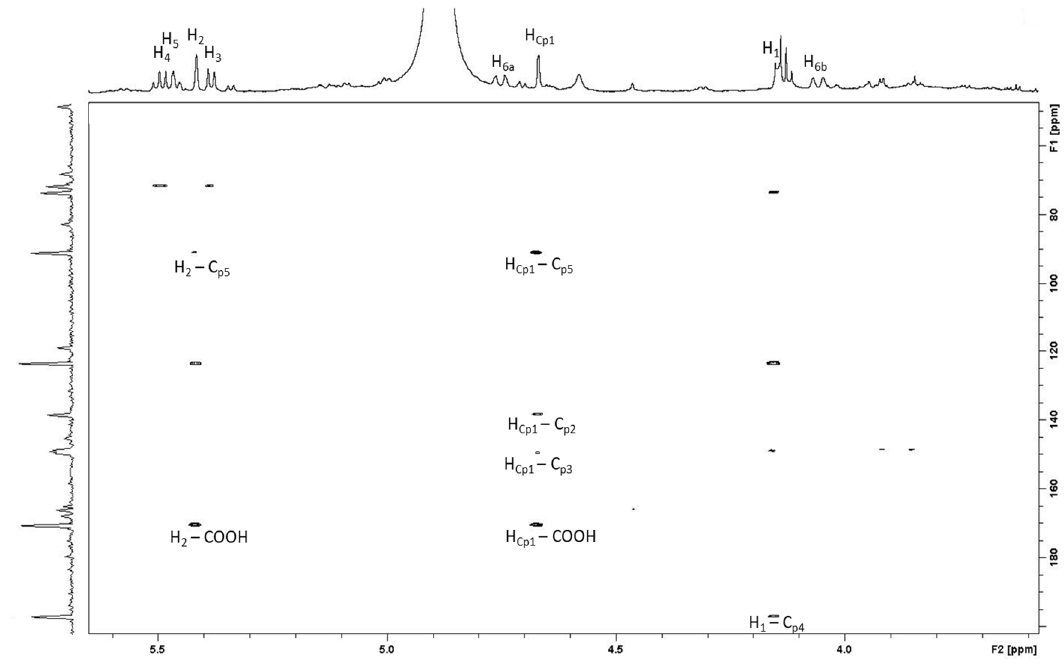
Figure 4. Zoom of the 1H-13C HMBC spectra in which the main correlations are indicated.